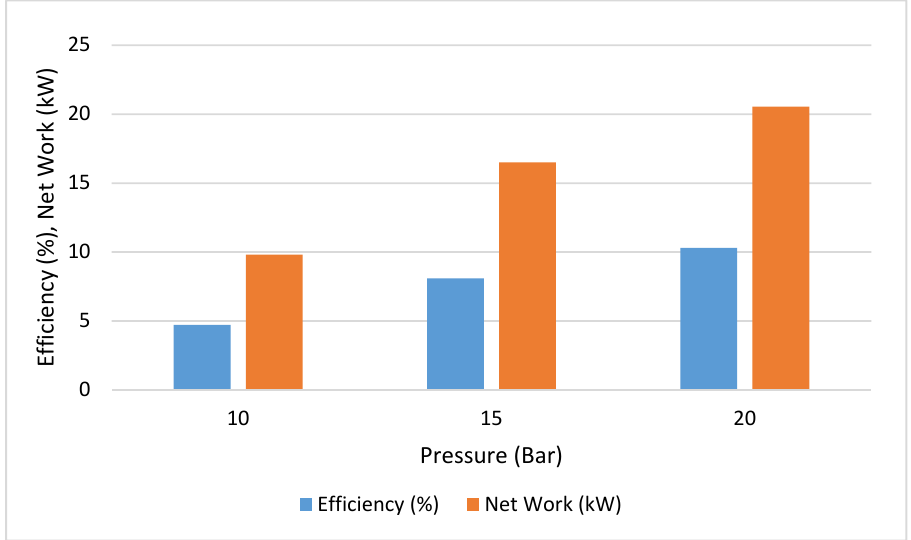
Figure 3. Efficiency and net work output from the Rankine cycles at 10, 15 and 20 bar.